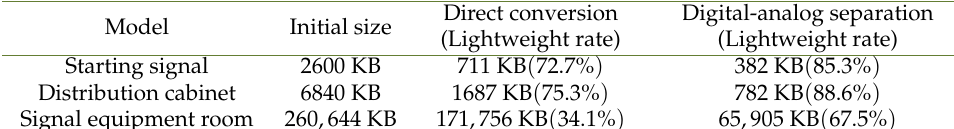
Table 2. Comparison of internal data lightweight